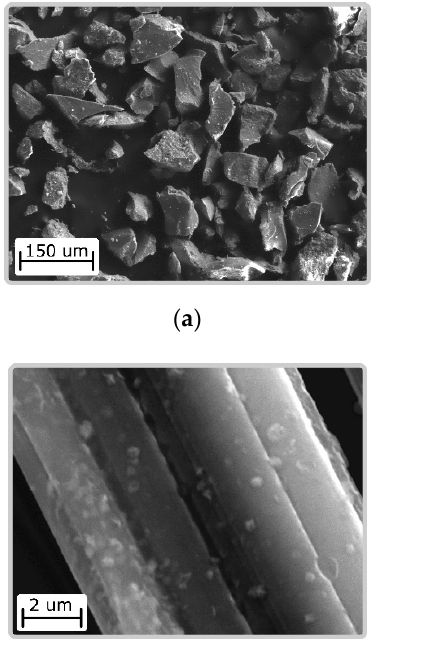
Figure 1. SEM images of samples ( a , b ) Ni(OH) 2 /CS with different magnification and ( c ) Ni(OH) 2 /CS/ACF.